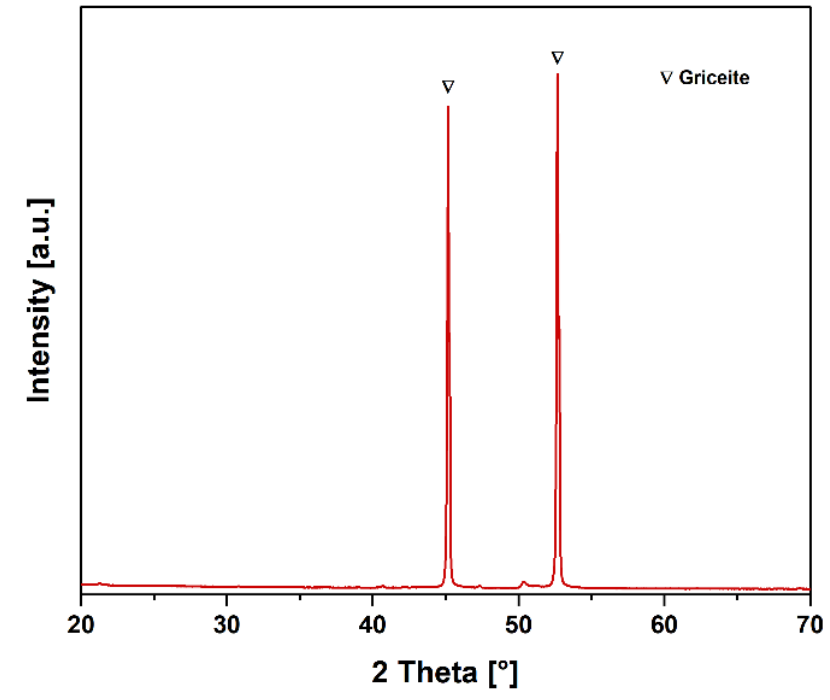
Figure 12. PXRD pattern of the filtrate of the fluid in the gas washing bottle. Table 9. ICP-OES analysis of relevant elements in the produced gas stream after the InduMelt experiment in